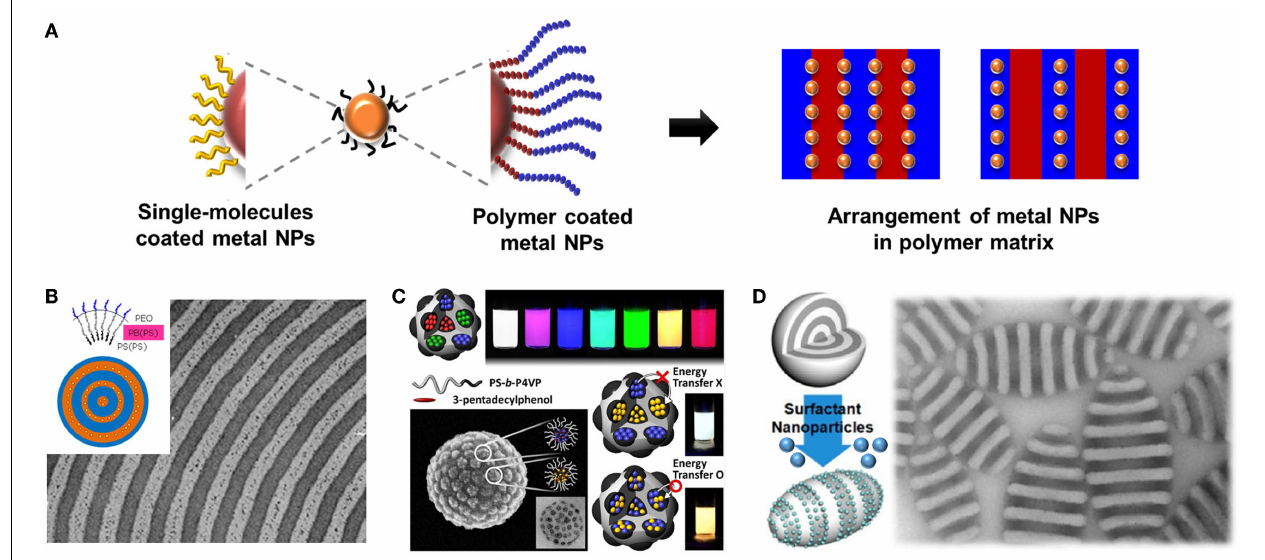
FIGURE 4 | (A) Schematic illustration of preparing hybrid BCP particles through ex situ method. (B) Cross-sectional TEM image of hybrid particles of PS-b-PB and PS-coated Au particles with PB-b-PEO (bottom left) and with PS-b-PEO stabilizer (bottom right). [Reprinted with permission from Jeon et al. (2009). Copyright 2009 American Chemical Society.] Lighter layers are the PS